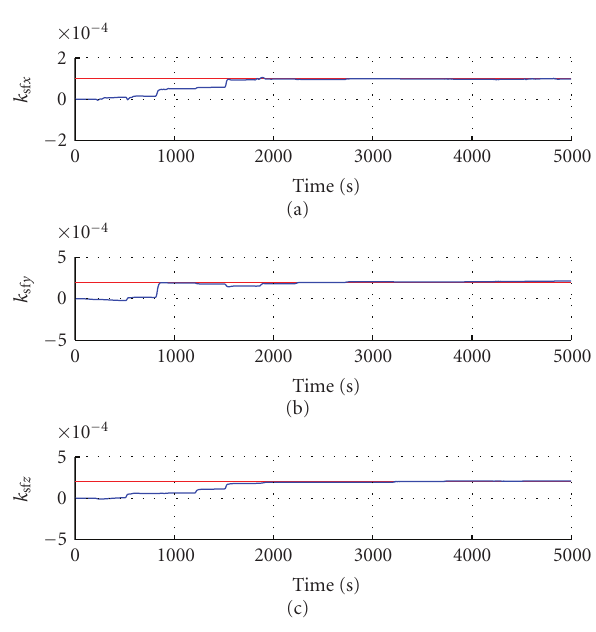
Figure 12: Scale factor